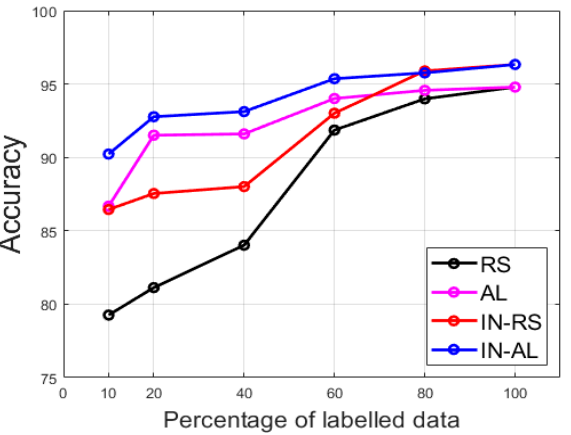
Figure 16. Evolution of the accuracy with other limitations in terms of labeling. The accuracy is shown for the 4 different cases discussed above.